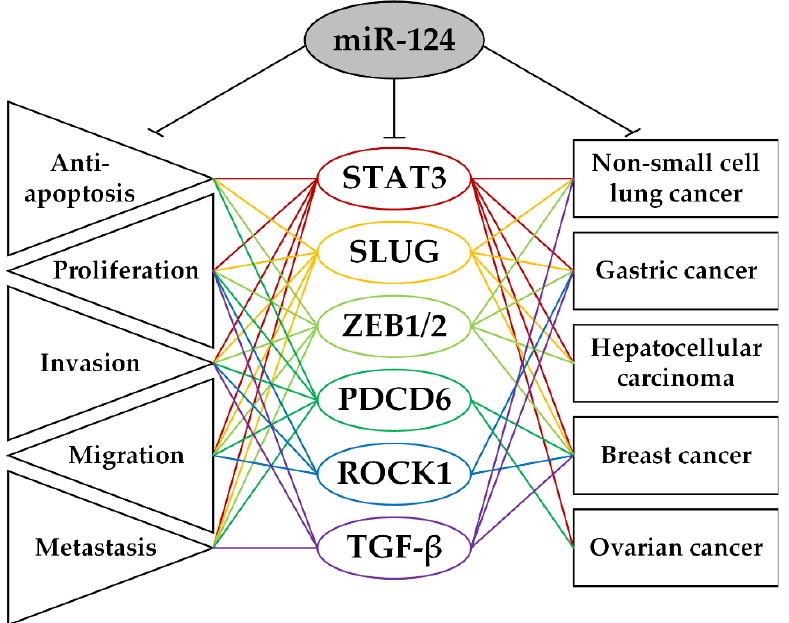
Figure 1. The scheme of differential regulation by miR-124: targets involved in the main biological processes in several common epithelial cancers. Central column—targets, left column—cell processes, right column—cancer types. The data from articles [3,4,16,28,30,40–46] were used.